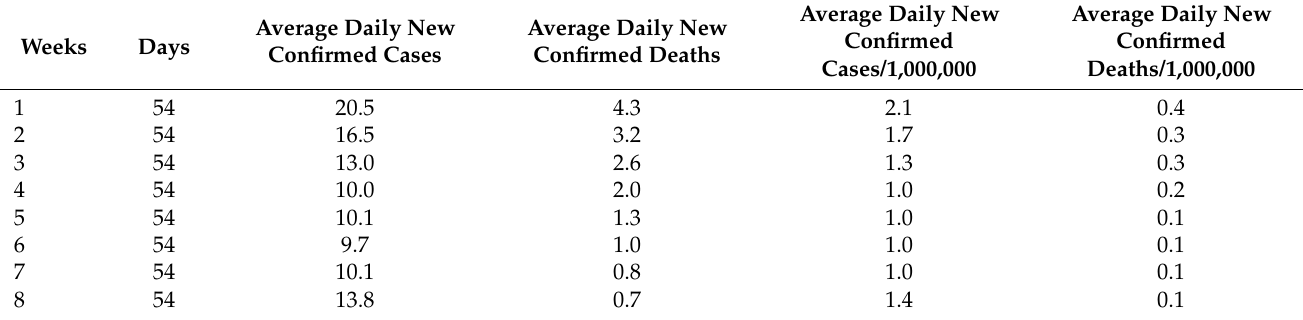
Table 4. Average number of cases after the lockdown in